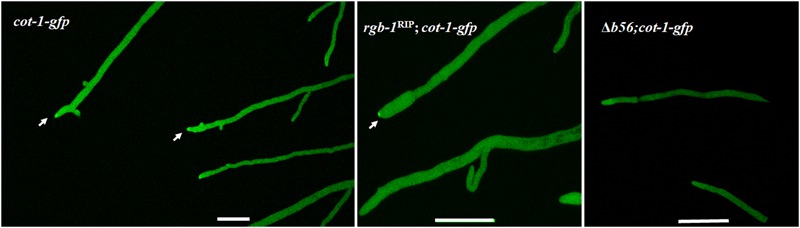
Localization pattern of COT1::GFP in rgb-1RIP and Δb56 backgrounds as determine by confocal microscopy. High abundance of COT1::GFP is evident in wt and I rgb-1RIP (marked by arrows), but not Δb56 backgrounds. Bars indicate 10 μm.